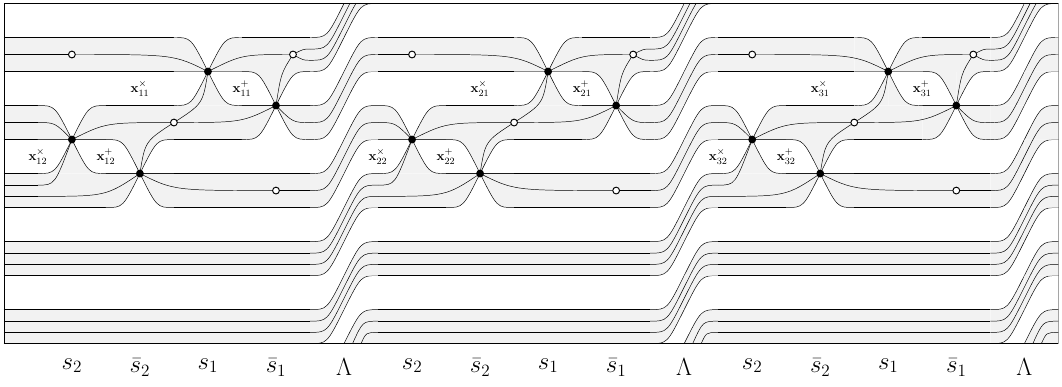
Figure 7 . Thurston diagram in the (3 ; 2) case, which appears from u = ( s 2 (cid:22) s 2 s 1 (cid:22) s 1 (cid:3)) 3